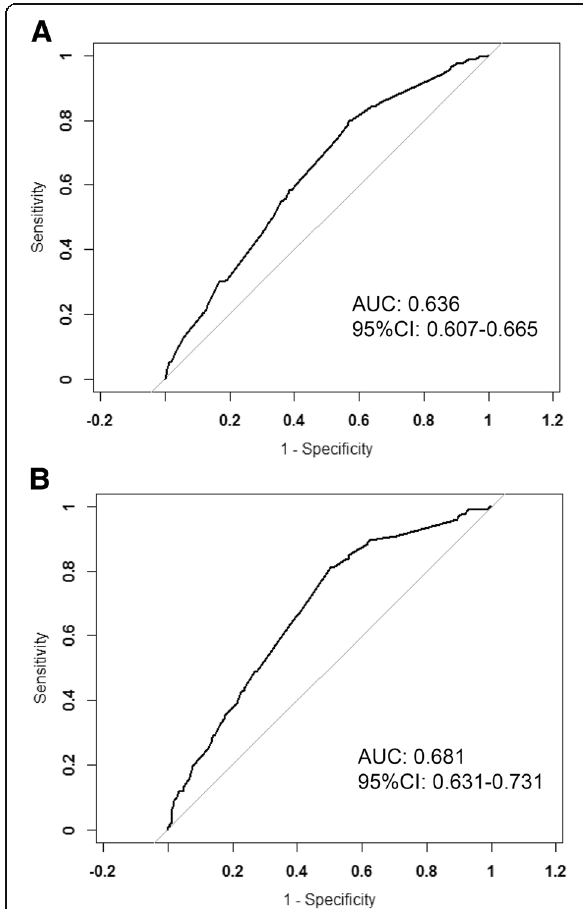
Fig. 3 Validation of the nomogram. ( a ) Internal validation using the ROC curve in the training set. The area under the ROC curve (AUC) is 0.636, 95% confidence interval (95% CI, 0.607 – 0.665). ( b ) External validation using ROC in the validation set. The AUC is 0.681 (95% CI, 0.631 –